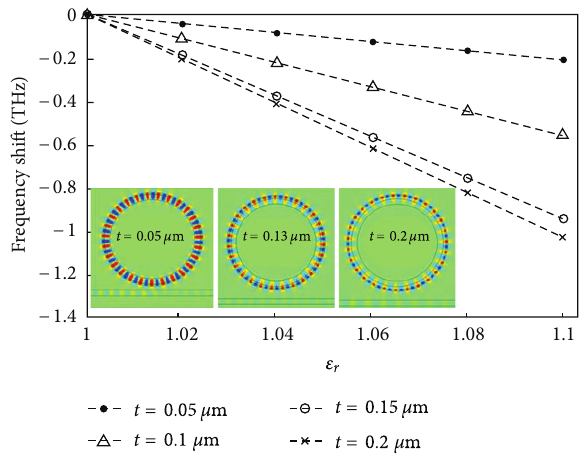
Figure 6: The relation between 𝜀 𝑟 and resonant frequency for dif- ferent metamaterial layer thickness. The insets show electric field distributions at resonant state for 𝑡 = 0.05 𝜇 m, 0.12 𝜇 m, and 0.2 𝜇 m, respectively [21].